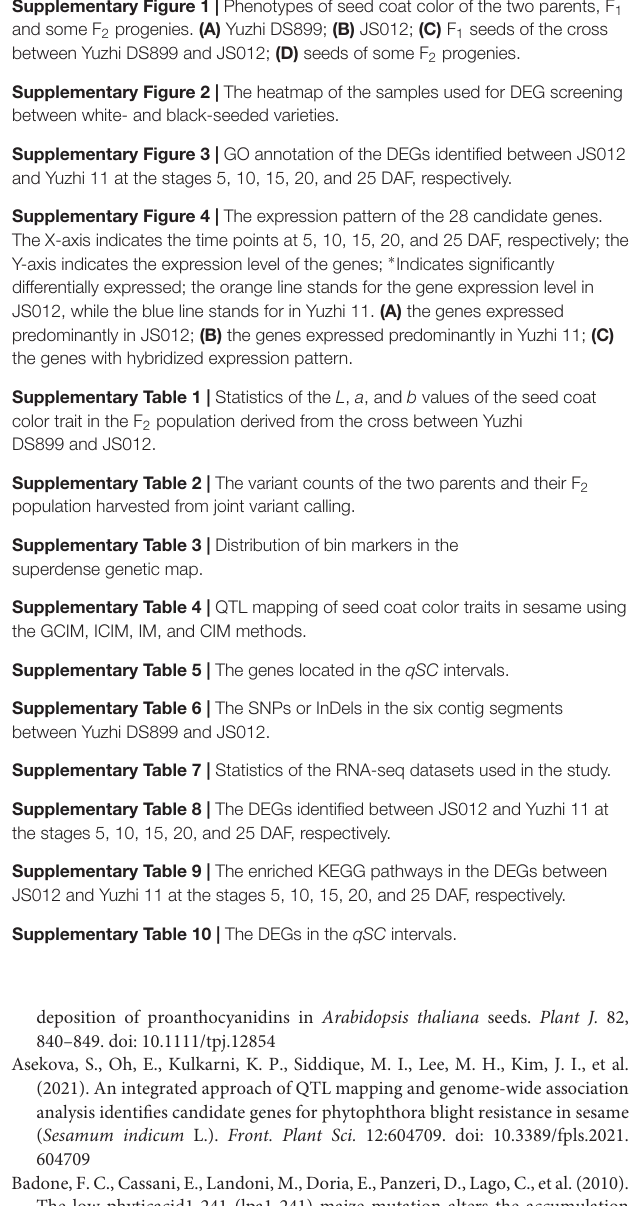
Supplementary Figure 2 | The heatmap of the samples used for DEG screening between white- and black-seeded varieties. Supplementary Figure 3 | GO annotation of the DEGs identified between JS012 and Yuzhi 11 at the stages 5, 10, 15, 20, and 25 DAF, respectively. Supplementary Figure 4 | The expression pattern of the 28 candidate genes. The X-axis indicates the time points at 5, 10, 15, 20, and 25 DAF, respectively; the Y-axis indicates the expression level of the genes; ∗ Indicates significantly differentially expressed; the orange line stands for the gene expression level in JS012, while the blue line stands for in Yuzhi 11. (A) the genes expressed predominantly in JS012; (B) the genes expressed predominantly in Yuzhi 11; (C) the genes with hybridized expression pattern. Supplementary Table 1 | Statistics of the L , a , and b values of the seed coat color trait in the F 2 population derived from the cross between Yuzhi DS899 and JS012. Supplementary Table 2 | The variant counts of the two parents and their F 2 population harvested from joint variant calling. Supplementary Table 3 | Distribution of bin markers in the superdense genetic map. Supplementary Table 4 | QTL mapping of seed coat color traits in sesame using the GCIM, ICIM, IM, and CIM methods. Supplementary Table 5 | The genes located in the qSC intervals.